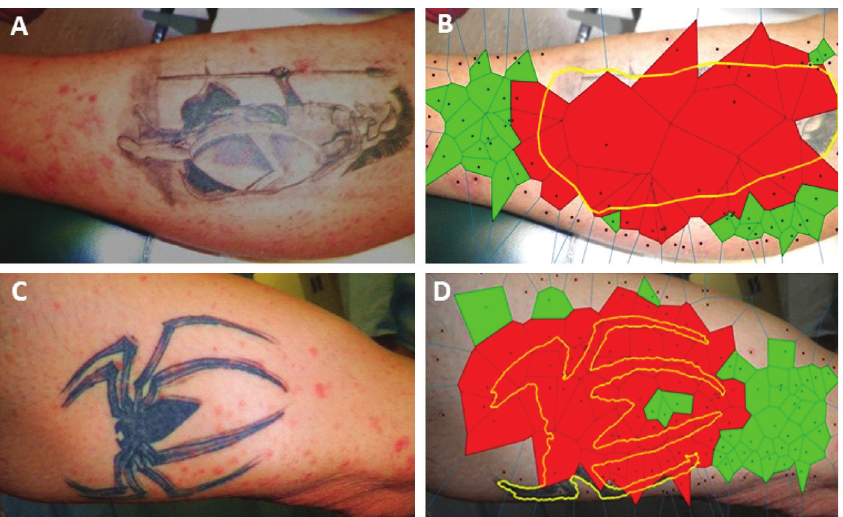
Figure 3: Tattoo #2 (panels (a) and (b)) and tattoo #3 (panels (c) and (d)). (a)–(c) Clinical pictures. (b)–(d) Voronoi patches intersecting (red) or not intersecting (green) tattooed skin areas (yellow